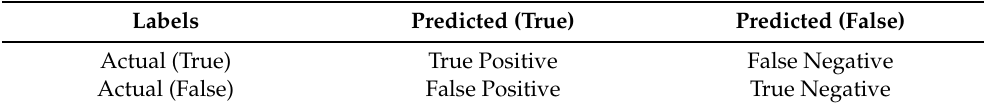
Table 2. Binary classifier confusion matrix. Labels Predicted (True) Predicted (False) Actual